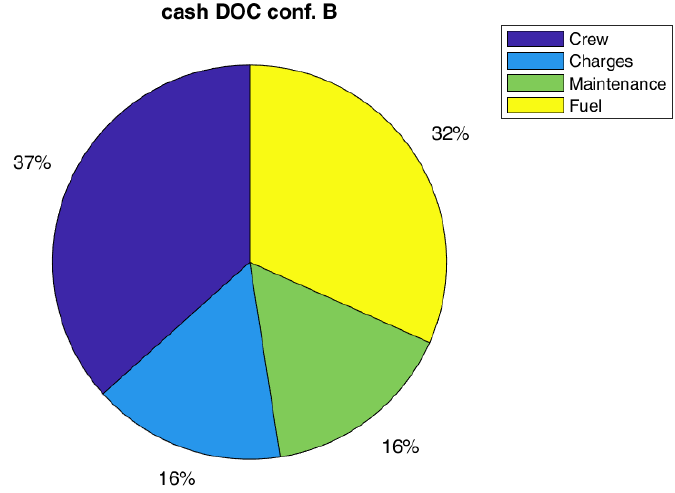
Figure 10. Pie chart of cash DOC for Config. B (SM = 1.75, with SHM).